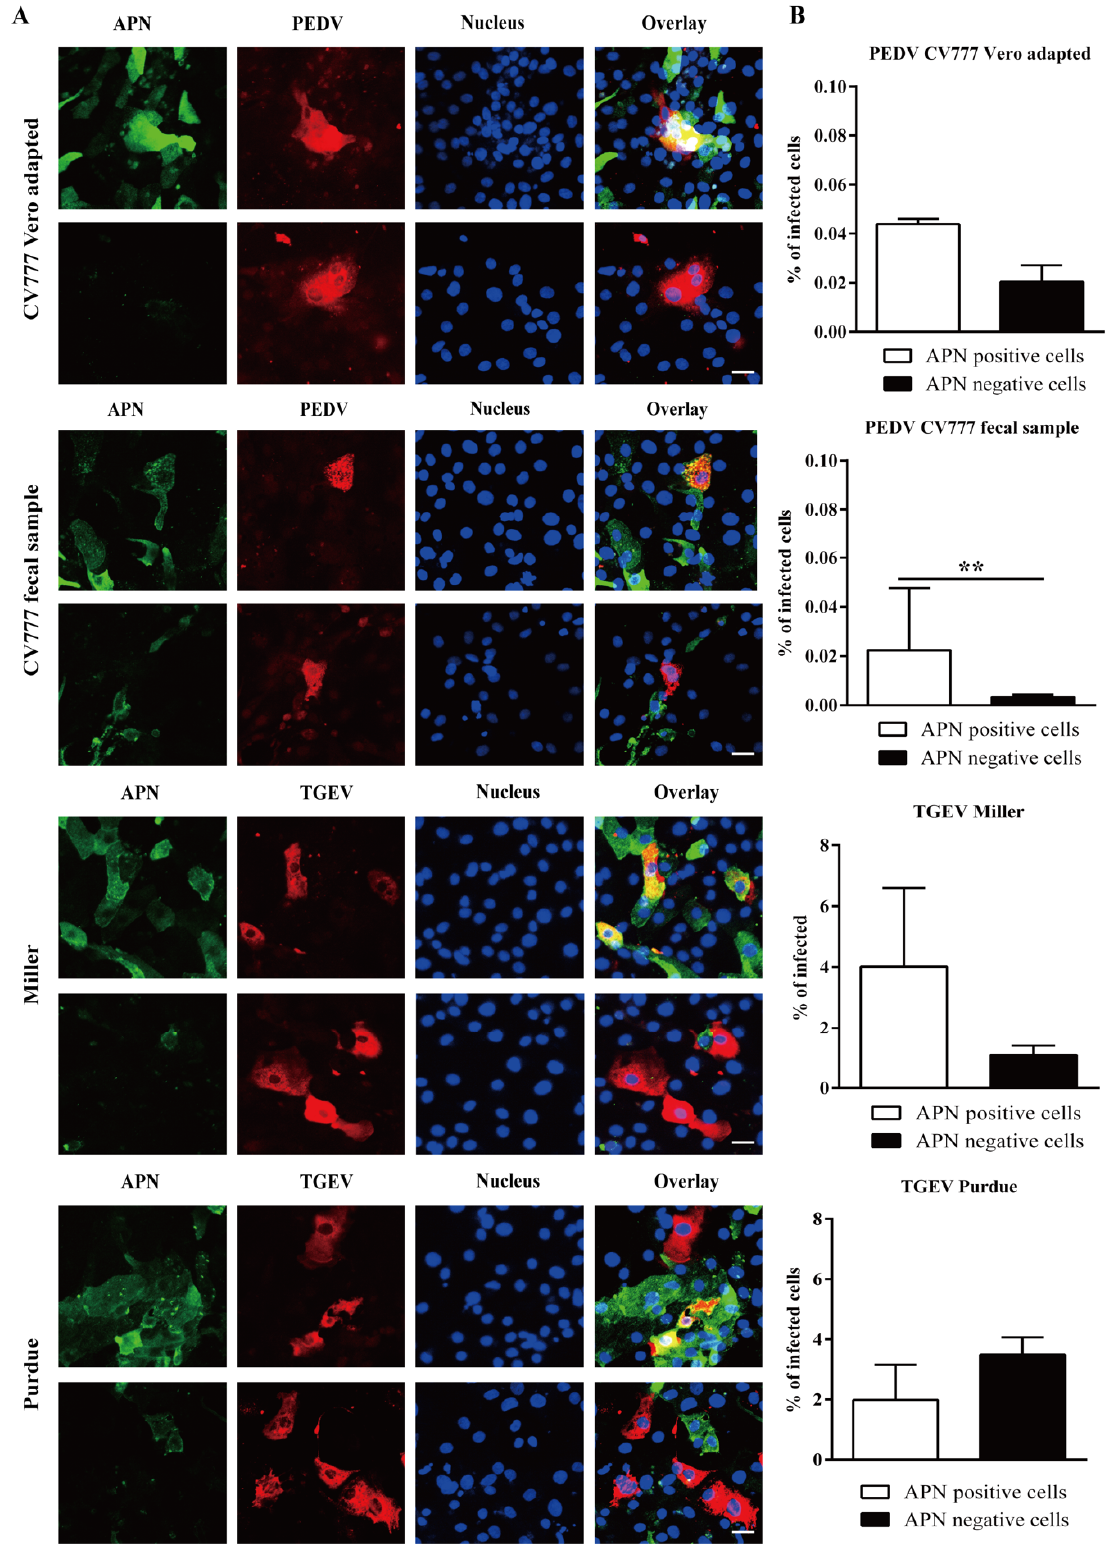
Figure 4. Infection of APN positive/negative enterocytes with PEDV and TGEV. ( A ) Double immunofluorescence staining of APN (green) and PEDV/TGEV (red) in primary enterocytes. Scale bar: 25 µm. ( B ) Percentage of infected cells within the population of APN positive and negative cells. Data are expressed as the mean ± SD of the results of three separate experiments. Statistically significant differences between APN positive and APN negative cells are presented as ** p < 0.01.